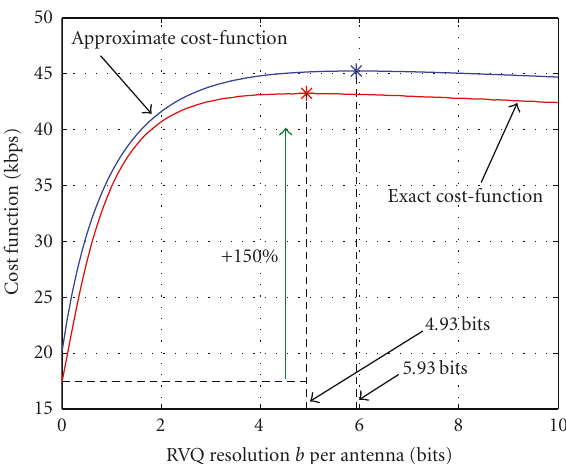
Figure 4: Comparison of the exact cost function (no approxi- mations used) from (6), and the approximate cost function from (32). The former is computed numerically. The average SNR in the optimal points (star-shaped markers) is set to SNR DL = 4 in both